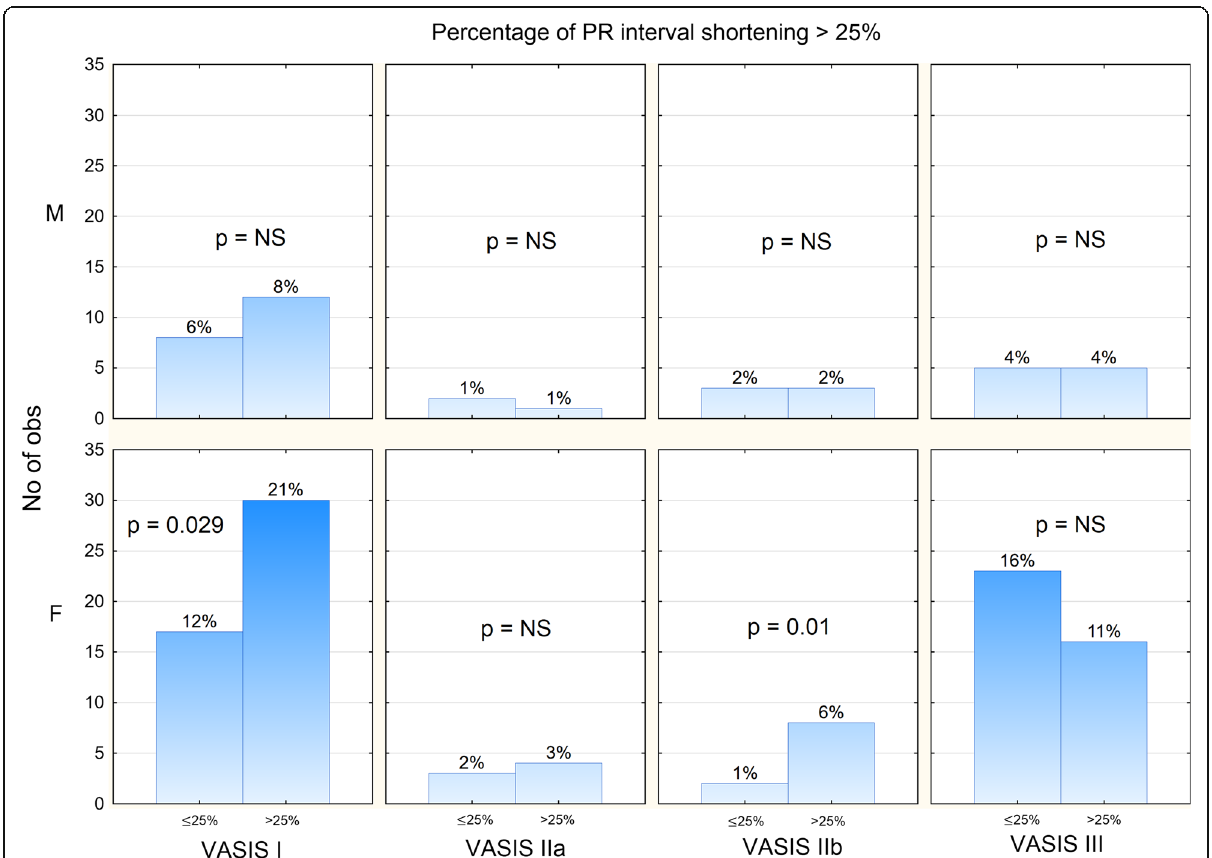
Fig. 2 Number and percentage of patients with PR interval change below and above 25% according to gender and VASIS syncope type. (M = male, F = female)